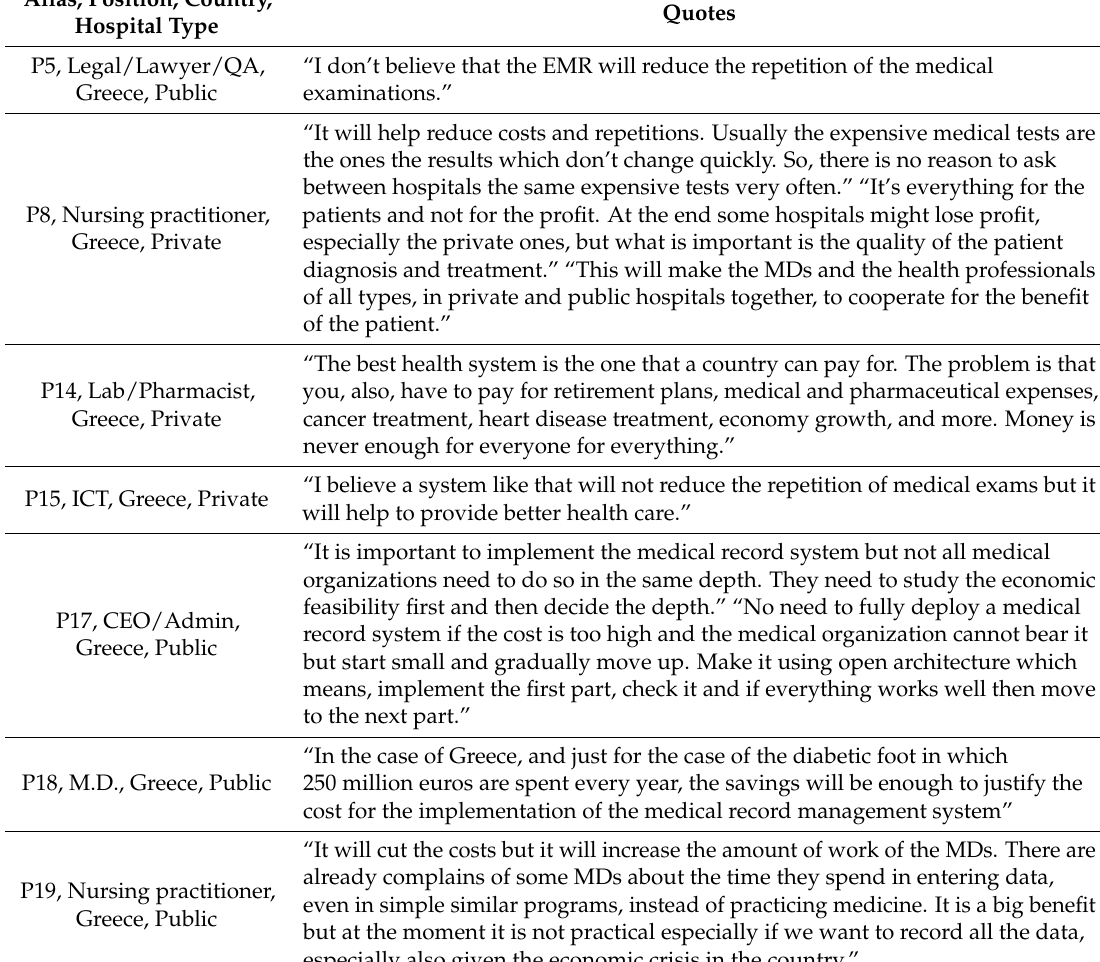
Table 2. Economic feasibility—significant